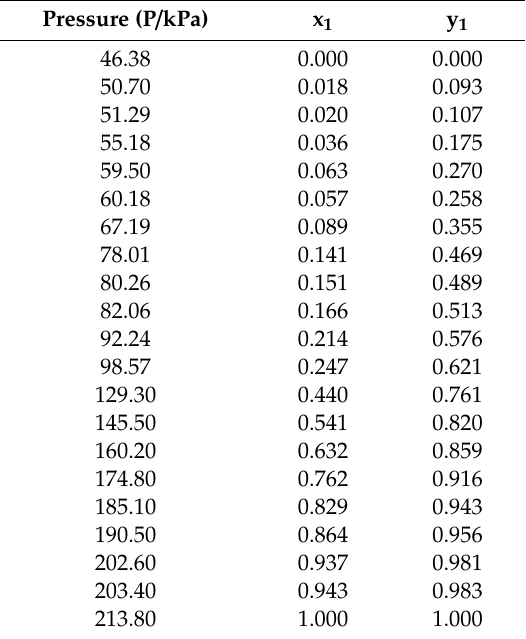
Table 1. Equilibrium data for acetone–butanol